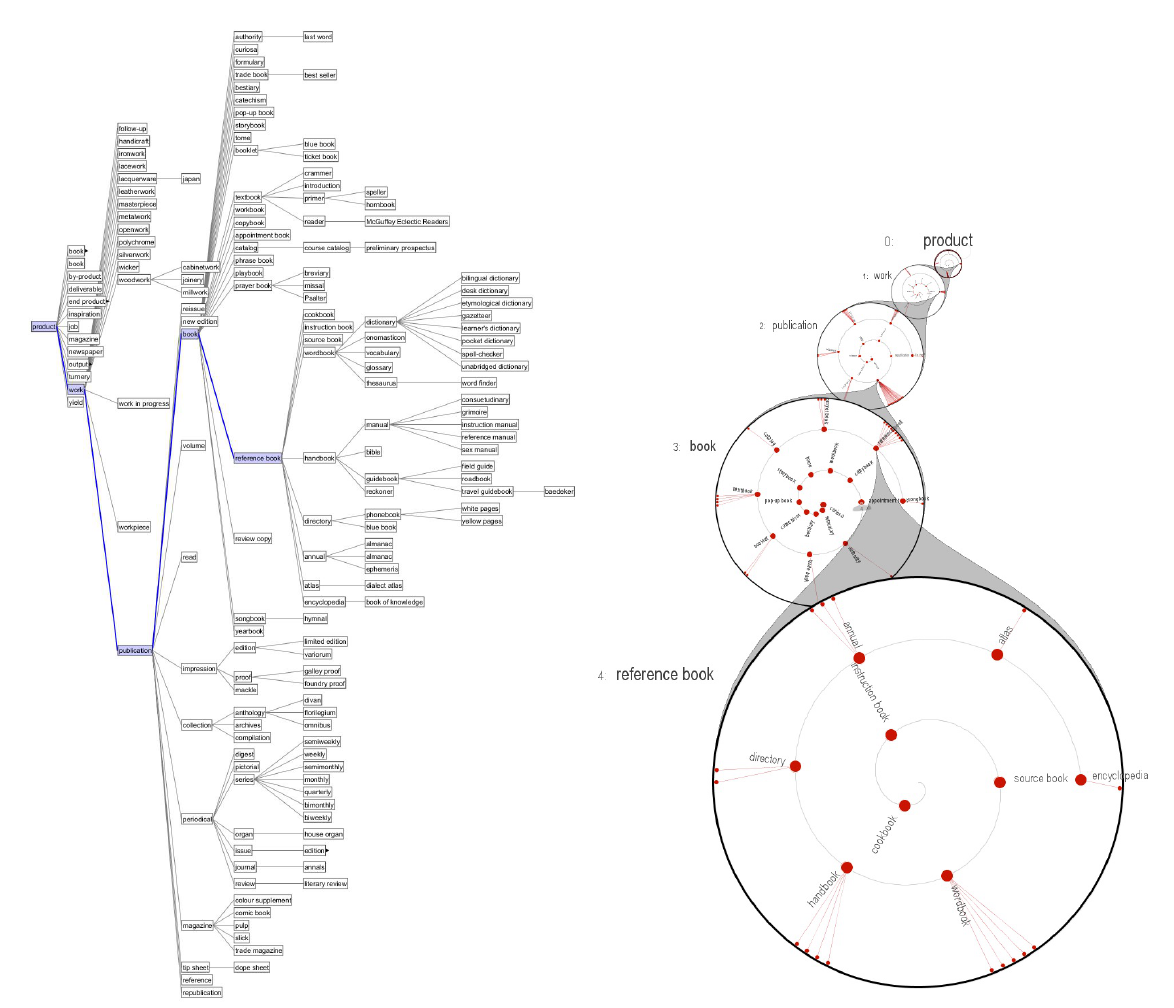
Figure 1. Left: SpaceTree, Right: PaisleyTree. Both trees show the subtree of Wordnet rooted at the word “Product" with 197 nodes and 9 levels.